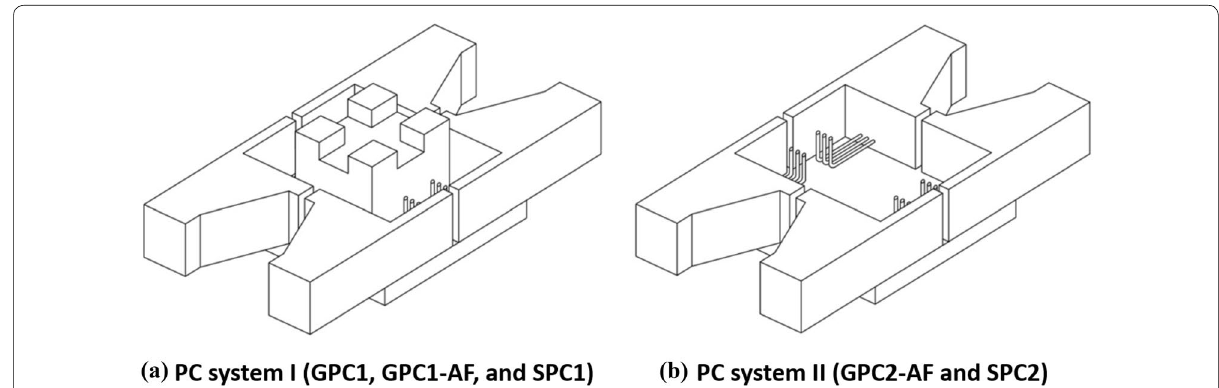
Fig. 6 Two PC double systems used in